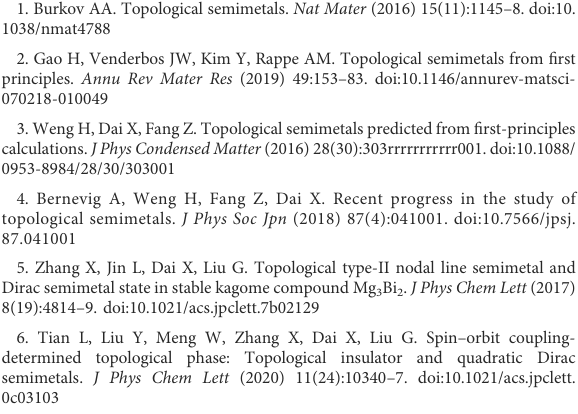
Figure 4. From Figure 4, one fi nds that the appearance of the Weyl nodal line along the X-M path further re fl ects the occurrence of the Weyl nodal net in 3D BZ.